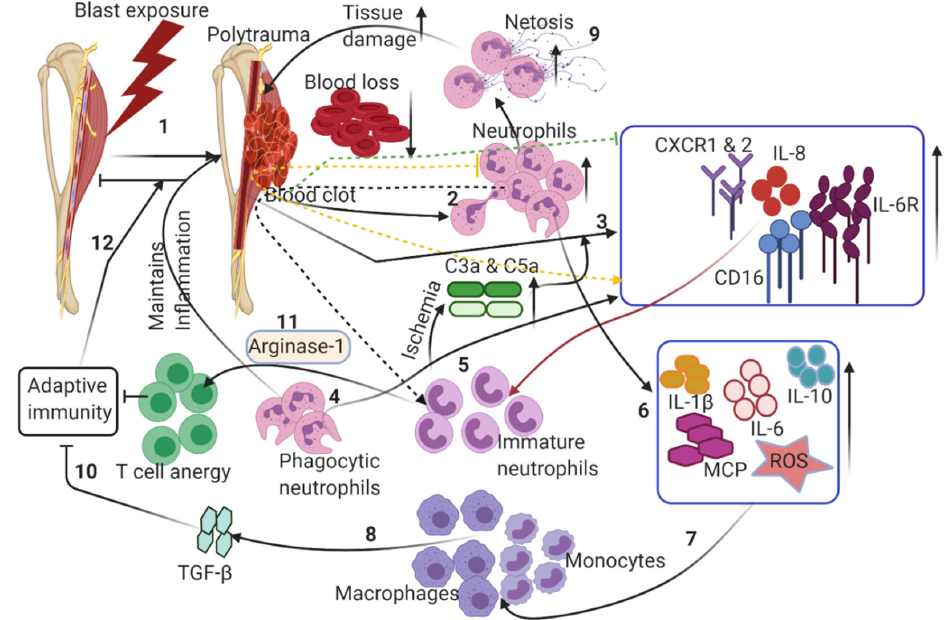
Figure 2. Dysregulation of innate immune responses following CTI: (1) blast-induced trauma in extremities damages multiple tissues, leading to hematoma. (2) Hematoma triggers neutrophil extravasation from the vasculature to the wound site. (3) A robust increase in pro-inflammatory cytokines and chemokines triggers neutrophils to clear the debris of dead cells. (4) Increased pro-inflammatory chemokines/interleukins induces the release of immature neutrophils, exacerbating the pro-inflammatory conditions. (5) An increase in immature neutrophils induces ischemia through the secretion of chemokines and proteases at the wound site. (6) Increased neutrophil infiltration further causes the upregulation of interleukins, chemokines and reactive oxygen species. (7) Monocytes and macrophages are activated to allow the transition from the acute inflammatory phase to the resolution phase. (8) Activated macrophages induce TGF- β . (9) Netosis of neutrophils induces robust pro-inflammatory responses, leading to excessive tissue damage. (10) Aberrant immune responses restrict the transition to adaptive immune responses. (11) Macrophages secrete arginase 1, thus inducing anergy in T cells. (12) These altered inflammatory responses maintain the presence of triggers for chronic inflammation, thus delaying the wound healing in CTI. Dotted arrows indicate the secondary induction of immune cells/cytokines, which inhibit normal healing responses by exacerbating pro-inflammatory responses. See text for further